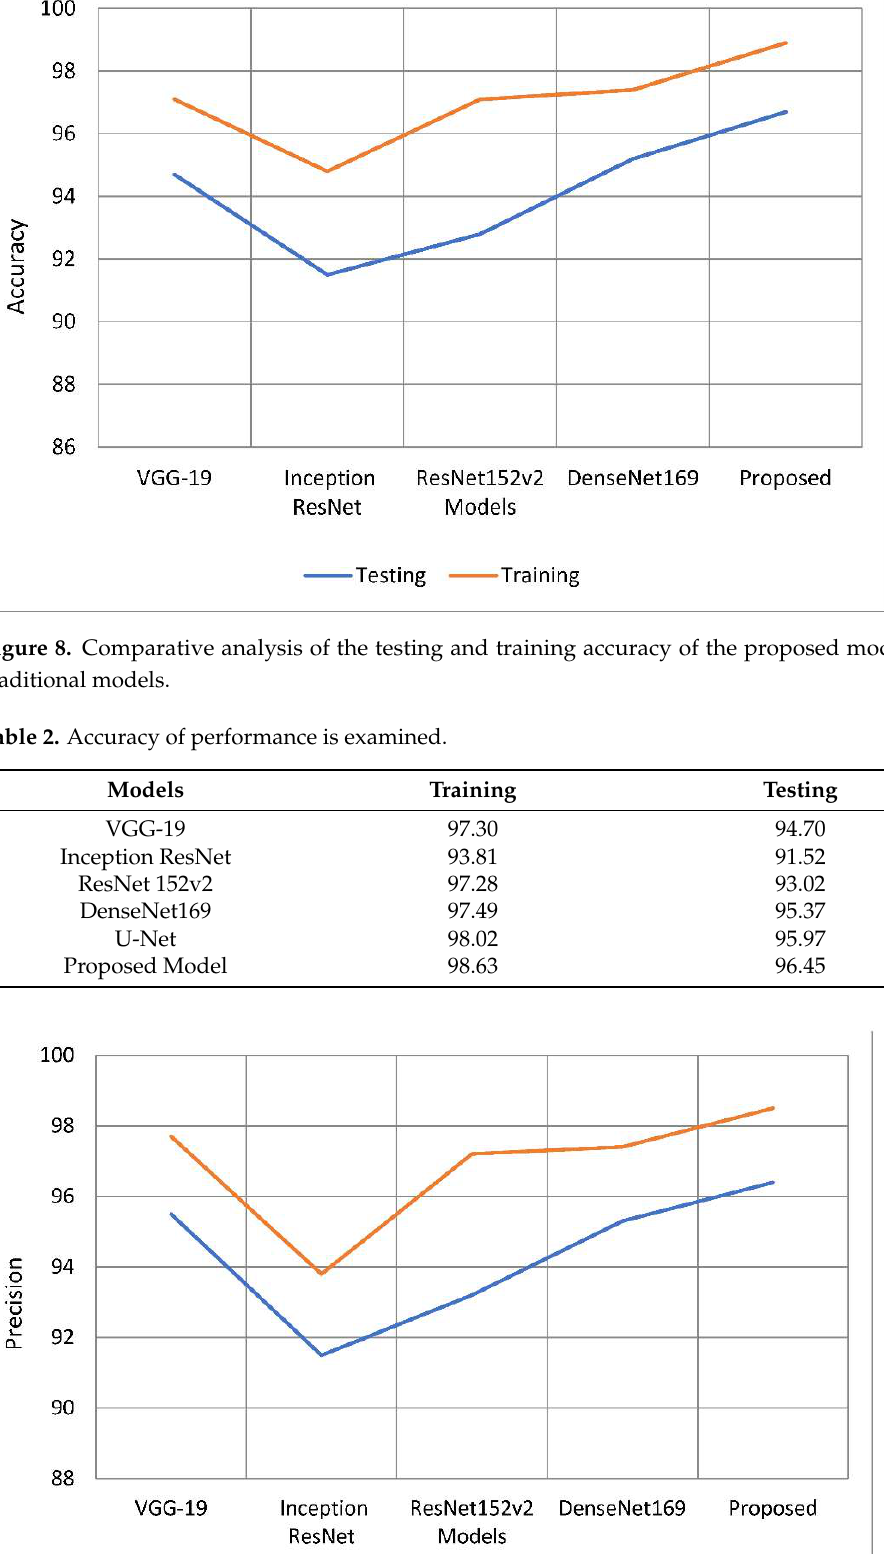
Figure 9. A comparative analysis of precision of the proposed model with traditional models.